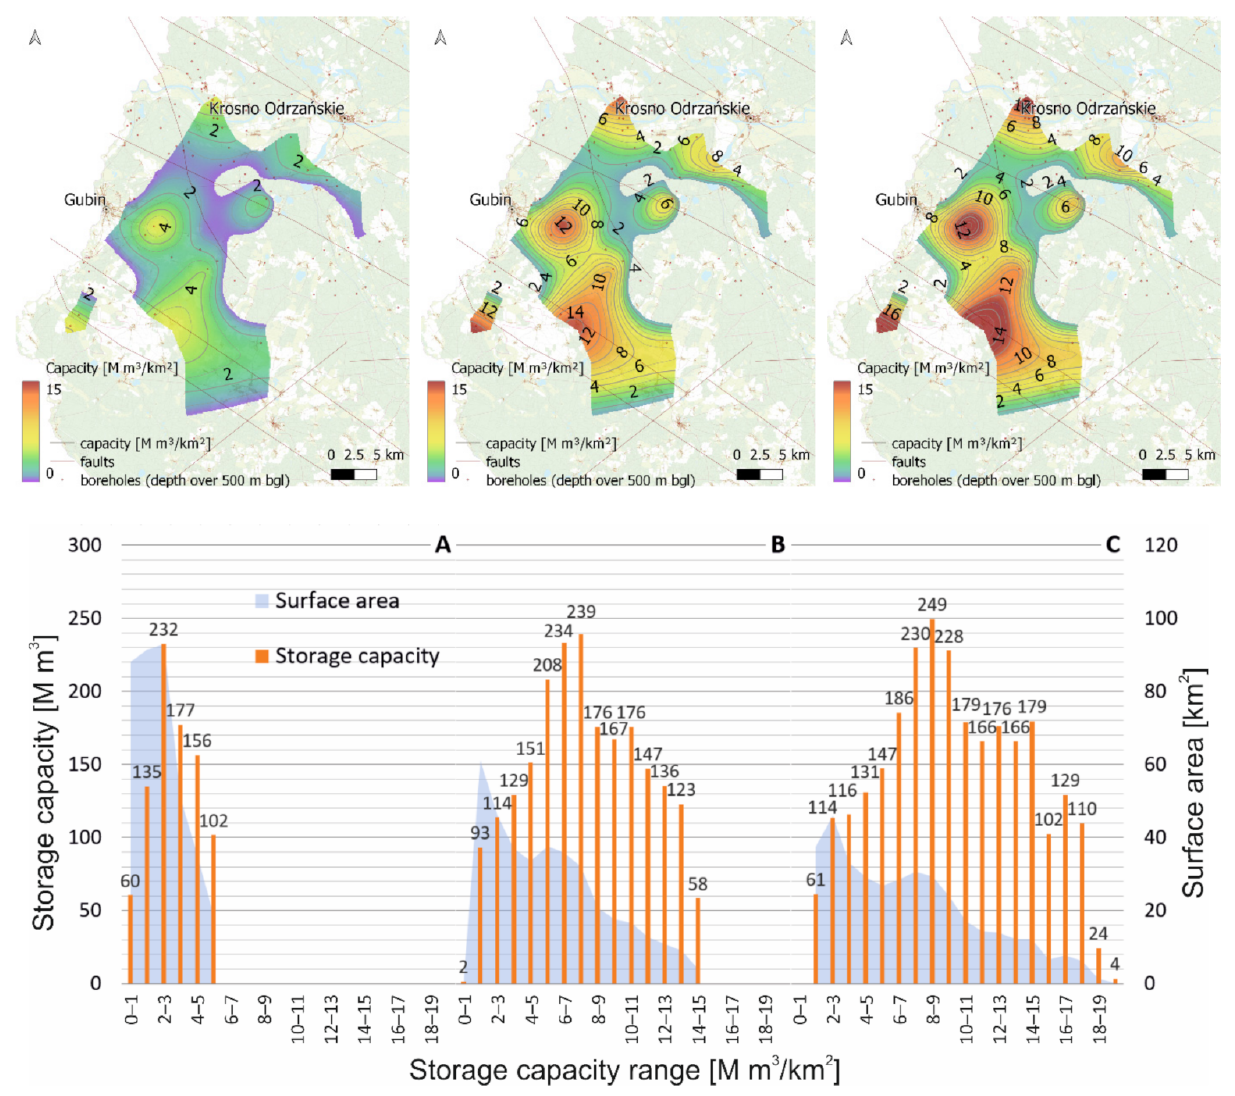
Figure A5. The storage capacity of liquid fuels in the rock salt layer in the western part of the Fore-Sudetic Monocline (( A ) initial state of operational storage, ( B ) target state of operational storage, ( C ) strategic